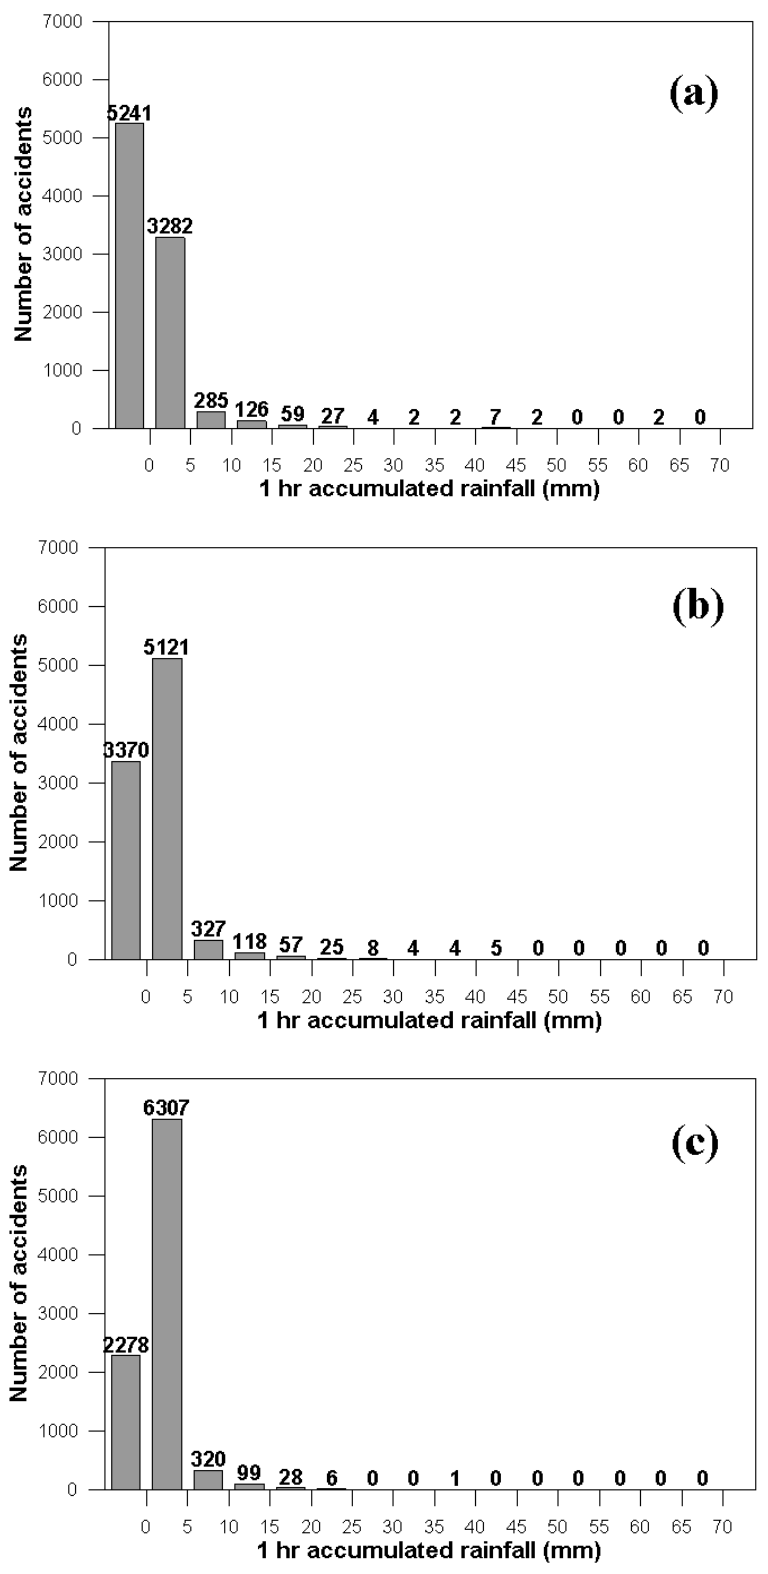
Figure 4. Number of fatal and severe accidents during 1 h accumulated rainfall measured by ( a ) rain gauges nearest to the accident location, ( b ) distributed rain gauges, and ( c ) radar.